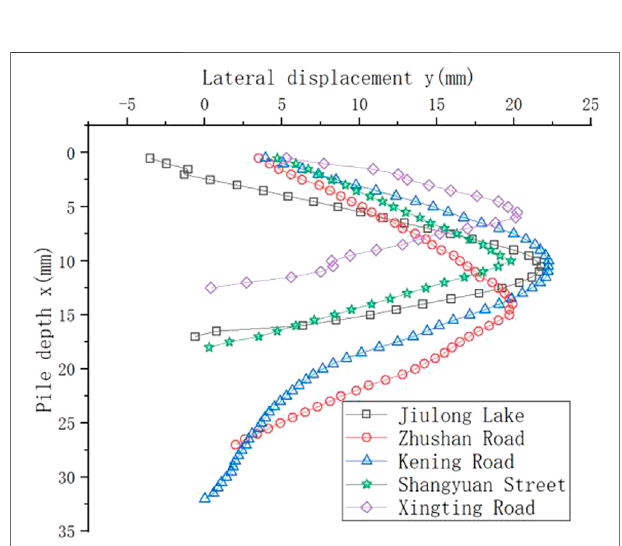
FIGURE 4 | Horizontal displacement curve of deep foundation